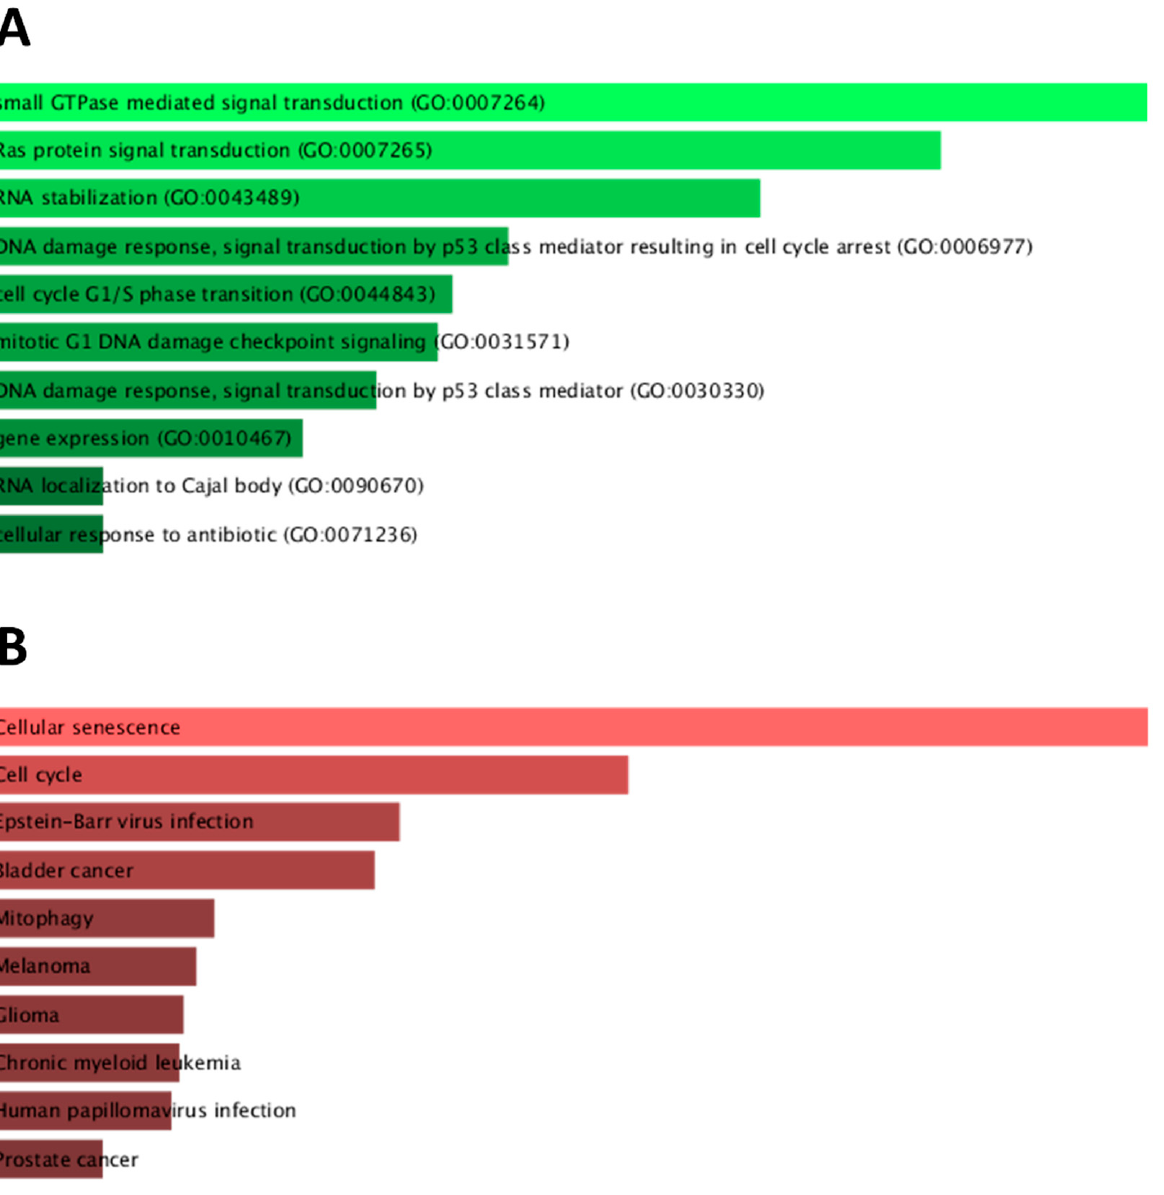
Figure 7. Bar charts of ( A ) biological processes and ( B ) KEGG pathways analyses in prognostic DEGs.